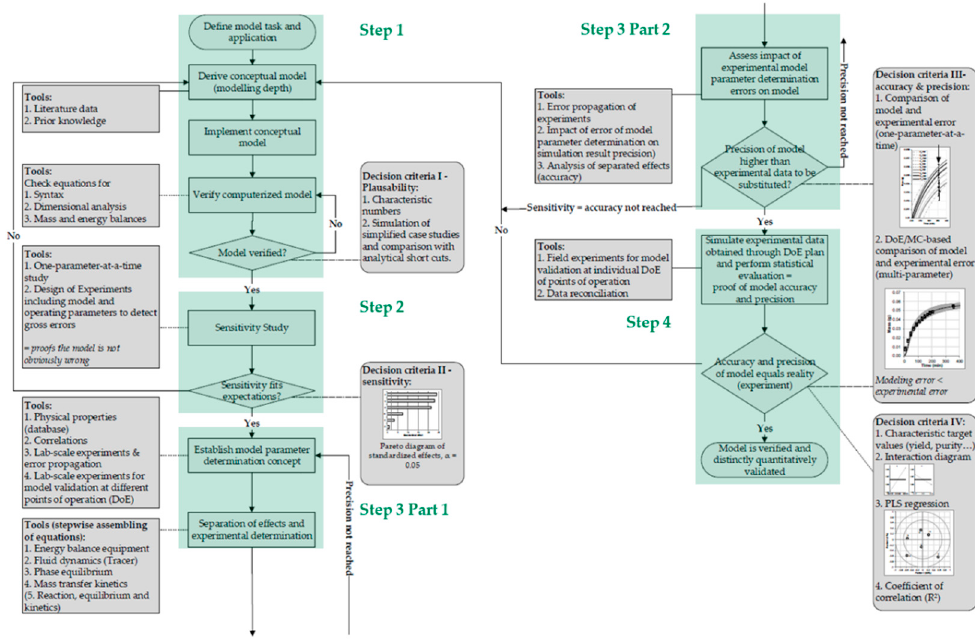
Figure 6. Workflow for process- and model development, adapted from [68].